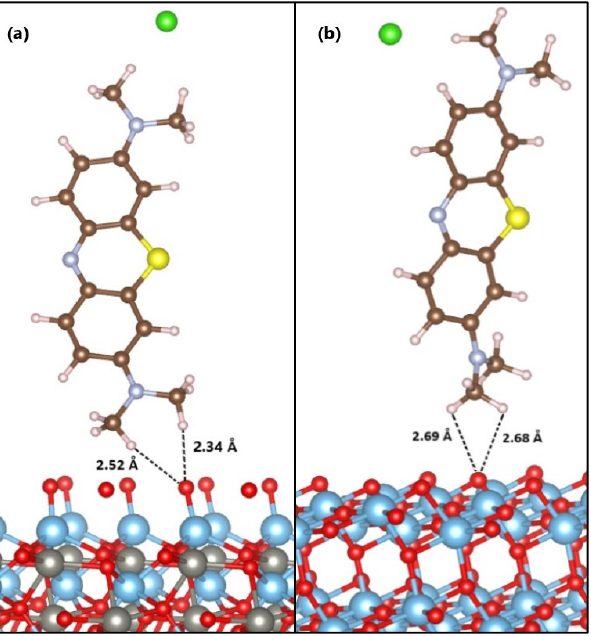
Figure 6. Anchoring modes of the MB molecule on the surface of ( a ) ZnTiO 3 and ( b ) TiO 2. The calculated adsorption energy value indicates that the MB molecule is strongly adsorbed on the ZnTiO 3 surface. The average distances from the hydrogen atoms of the MB molecule (H MB ) to the surface plane of ZnTiO 3 are O (oxide) -H MB = 2.34 Å and O (oxide) -H MB = 2.52 Å. Moreover, the adsorption energy value of the MB molecule on the TiO 2 surface indicates a weaker interaction than on ZnTiO 3 (E ads = − 0.113 eV). The average distances from the hydrogen atoms of the molecule to the plane of the TiO 2 surface are O (oxide) -H MB = 2.68 Å and O (oxide) -H MB = 2.69 Å. 3. Discussion 3.1. Optimization and Electronic Structure of ZnTiO 3 and TiO 2 The description of the electronic structure of materials involving transition metals with DFT is often complicated due to correlation effects involving 3 d electrons [59]. How- ever, since the transition metals of the oxides studied in this paper are formally in the 3 d 0 or 3 d 10 , neither TiO 2 nor ZnTiO 3 are strongly correlated materials; consequently, a simple DFT approach allowed us to accurately calculate the conduction and valence bands of ZnTiO 3 and TiO 2 . The literature shows that ZnTiO 3 has a relatively wide bandgap (E g = 2.73–3.70 eV), the value of which depends on the synthesis conditions [60,61]. In our study, the ZnTiO 3 and TiO 2 structures presented indirect bandgap values of 2.20 and 2.31 eV, respectively, which were calculated by the GGA-PBE method. In contrast with the experimental data, 3.18 eV for ZnTiO 3 [15] and 3.20 eV for TiO 2 [53], the theoretical values are lower, and this may be due to the widely known DFT-underestimation of the bandgap in most materials [1,15]. Therefore, a Hubbard U approximation term was adopted to accurately describe the electronic structures [12,62]. The new indirect bandgap values calculated by GGA + U were 3.16 and 3.21 eV for ZnTiO 3 and TiO 2 , respectively, which are consistent with the aforementioned experimental data. As can be seen, mixed oxide ZnTiO 3 has lower bandgap energy than TiO 2 . According to the literature, this occurs due to the replacement of Ti (3 d 0 ) atoms with Zn (3 d 10 ) that induce O 2 p -Zn 3 d 10 repulsion [21,63]. Table 1 shows the comparison of the bandgap energy values of the ZnTiO 3 and TiO 2 calculated in this study with other energy values reported in the literature.